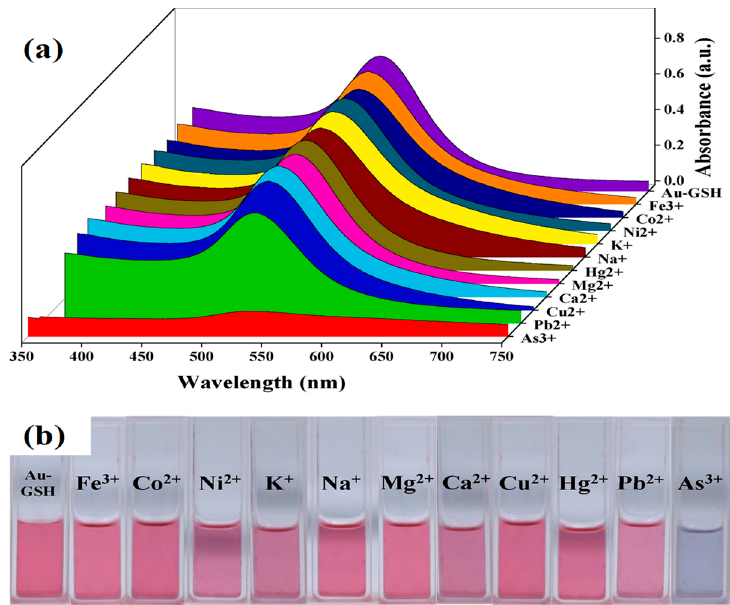
Figure 4. ( a ) Absorption spectra of GSH-AuNPs in the presence of different metallic ions and ( b ) the digital photograph of color changes of GSH-AuNPs in the presence of different metallic ions at a concentration of 10 ppb and while arsenic (III) was 1 ppb [65]. Copyright 2020, reproduced with permission from Elsevier B.V., Amsterdam, The Netherlands.